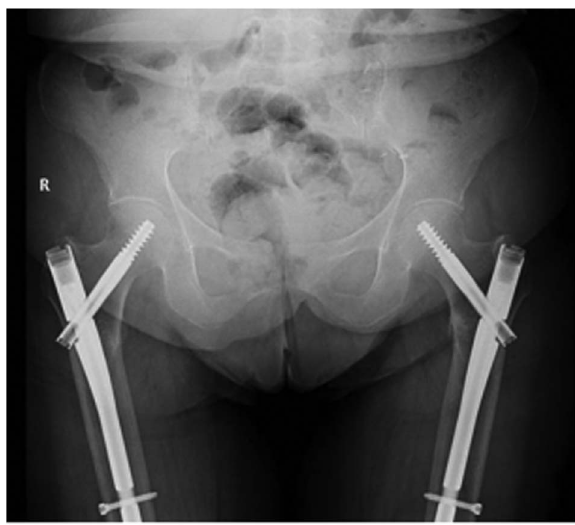
Figure 3. Postoperative antero-posterior pelvis view.